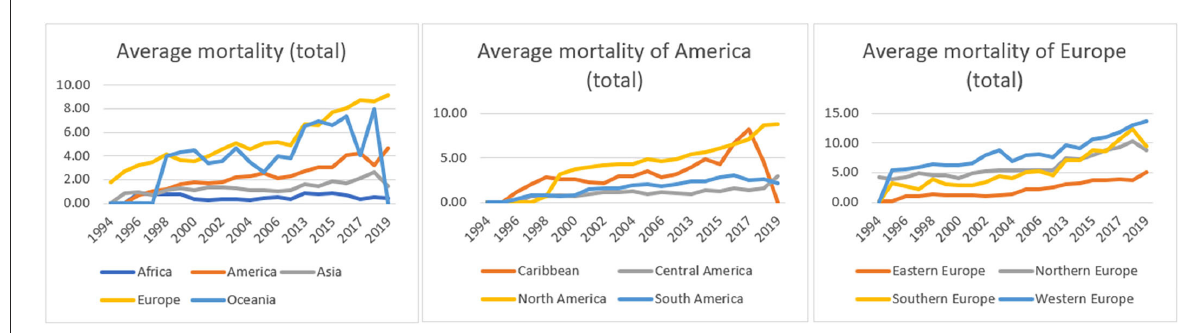
FIGURE2 Parkinson’s disease-related mortality according to age and according to the classification of the Human Development Index (HDI).